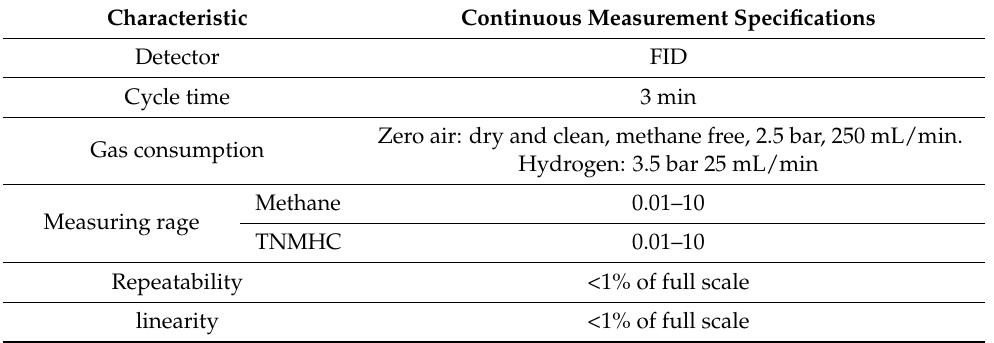
Table 3. Specifications of CH 4 continuous measuring